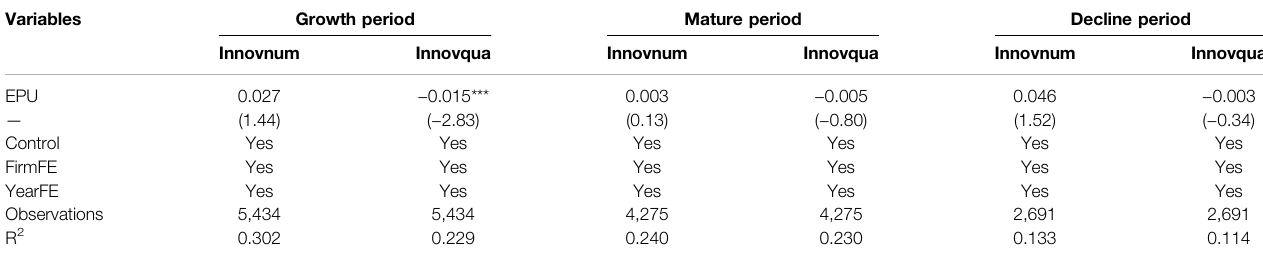
TABLE 7 | Heterogeneity of enterprise